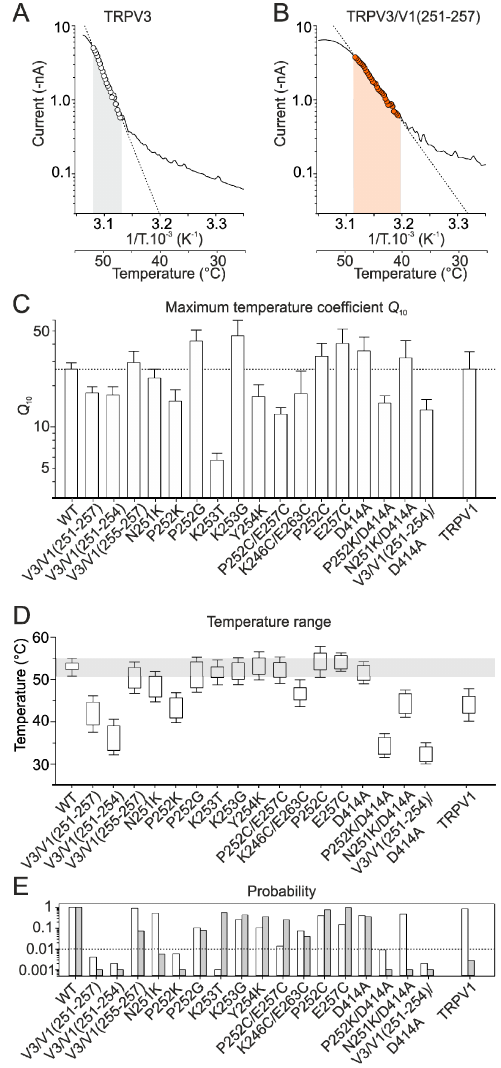
Figure 4. Statistical evaluation of maximum apparent Q 10 and the estimated temperature thresholds for all the mutants. ( A , B ) Arrhenius plot of heat responses obtained from two representative cells expressing either wild-type ( A ) or mutant ( B ) channels. Temperature coe ffi cient Q 10 was determined for the initial heat response of each cell over the temperature range at which the Arrhenius plot was linear (dashed lines, r 2 = 0.98–0.99). Temperature ranges used for the estimation of Q 10 are indicated (shadow area). ( C ) Summary of the maximum temperature coe ffi cient Q 10 values for all the measured chimeras and mutants, compared with wild-type TRPV3 and rat TRPV1. The horizontal dotted line indicates average maximum Q 10 of wild-type TRPV3. ( D ) Average temperature ranges over which Arrhenius plot of the heat-induced currents was linear and used for the estimation of the maximum Q 10 . Horizontal grey area indicates the upper and lower limits of the temperature range for wild-type channels. ( E ) The probabilities obtained from the t -tests that were performed in order to determine if there was a significant di ff erence between the Q 10 (white vertical bars) and the lower temperature limit for the maximum Q 10 estimation (grey vertical bars) for the wild-type and the individual mutants. The level of significance p = 0.01 is indicated with a dotted horizontal line.